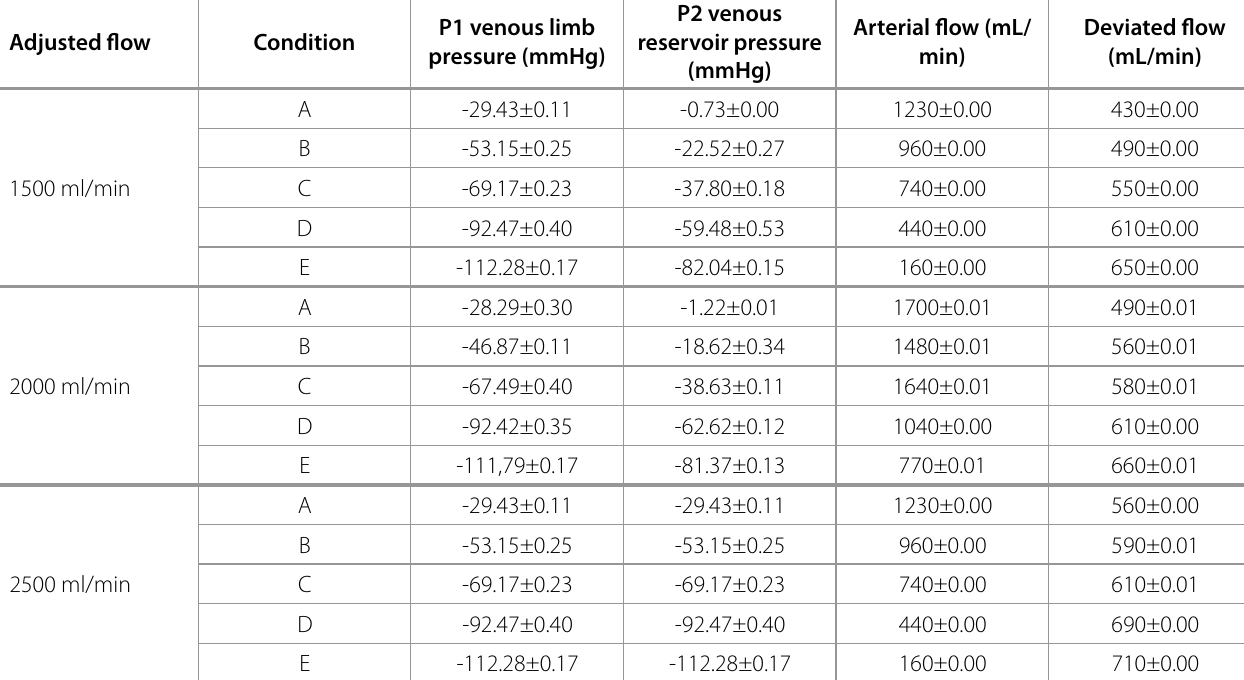
Table 2 . Mean venous limb pressure (P1), mean venous reservoir pressure (P2), and arterial line flow (forward flow) measured at baseline flow of 1500, 2000, and 2500 mL/min with vacuum off and increments of vacuum-assisted venous drainage levels (-20, -40, -60, and -80; conditions A to E) keeping the purge line open.